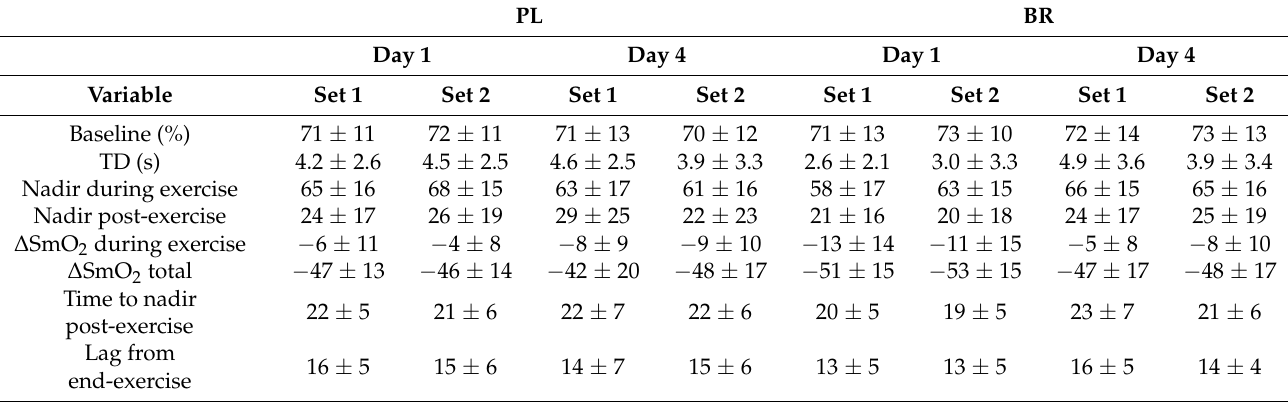
Table 3. Muscle oxygenation of the vastus lateralis during a back squat exercise protocol for determi- nation of power and velocity following acute and multiday nitrate